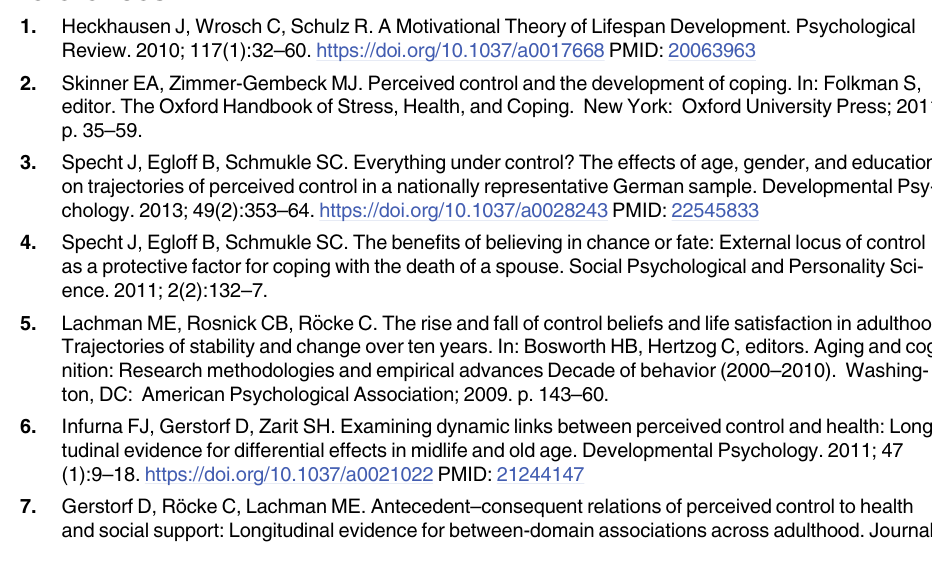
S1 Table. Examples for the coding of the selection/post-loss difference, anticipation, social- ization, short-term, and long-term